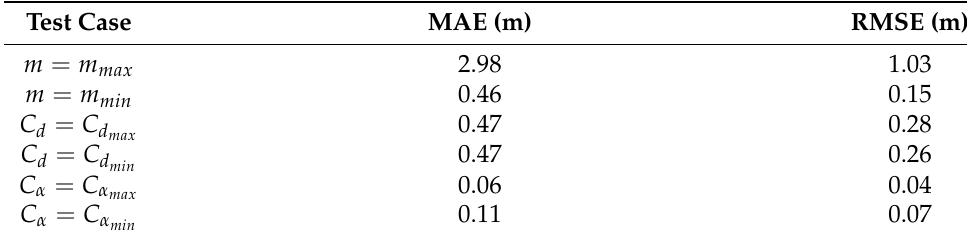
Table 11. MAE and RMSE for d r .